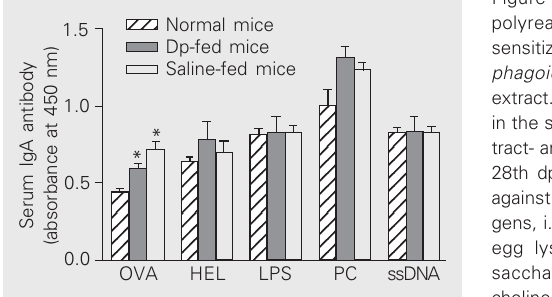
Figure 5. Reactivity of secretory polyreactive IgA anti- bodies in sensitized mice fed a Dermatophagoides pteronyssinus (Dp) extract. Fecal pellets were col- lected from mice on the 9th and 28th days post-immu- nization (dpi) and extracts were obtained with PBS washes. Secretory IgA antibodies present in the samples were tested by ELISA against a panel of dif- ferent self and non-self antigens, i.e., Dp extract, oval- bumin (OVA), hen egg lysozyme (HEL), lipopolysaccha- ride (LPS), phosphorylcholine (PC)-BSA, and ssDNA. Data are reported as means ± SEM for 3-5 mice in each group of four independent experiments. *P < 0.05 compared to saline-fed mice; **P < 0.05 com- pared to normal mice (unpaired Student t -test).